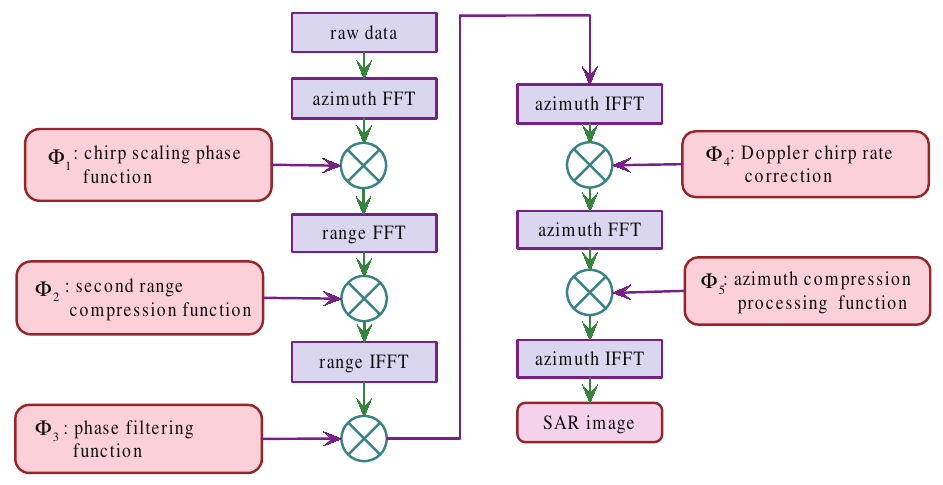
Figure 7. The NCS-based azimuth-variant bistatic SAR imaging algorithm.